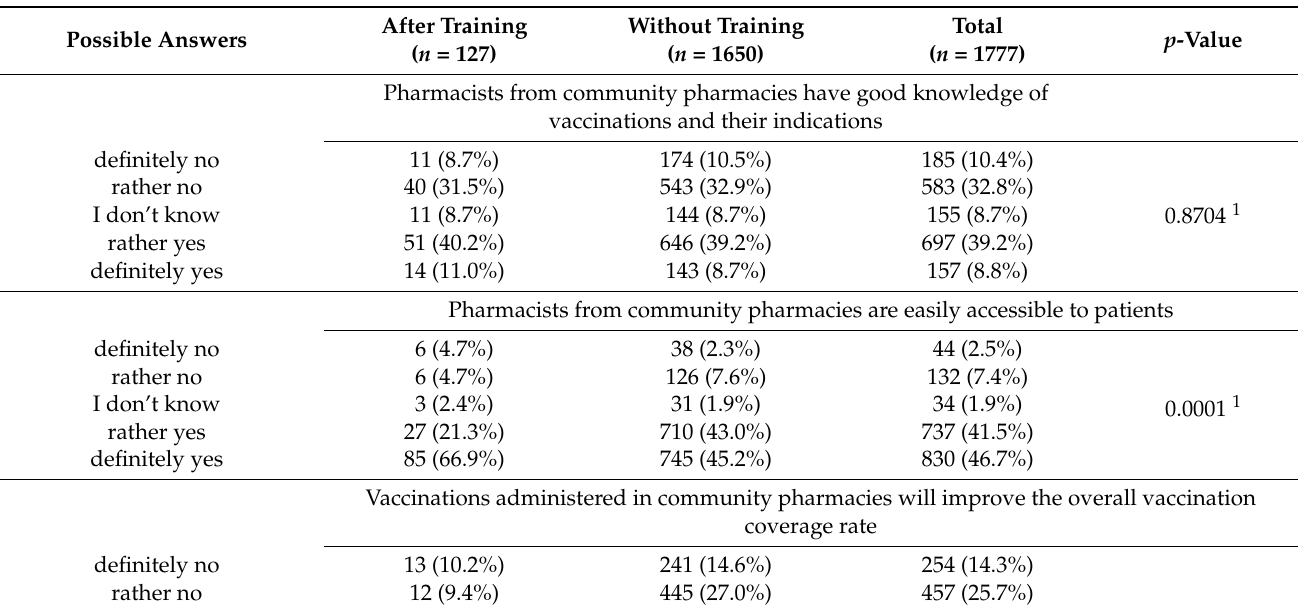
Table 2. Justification of readiness to provide vaccination services in pharmacies by the pharmacists participating and not participating in the Pharmacists Without Borders